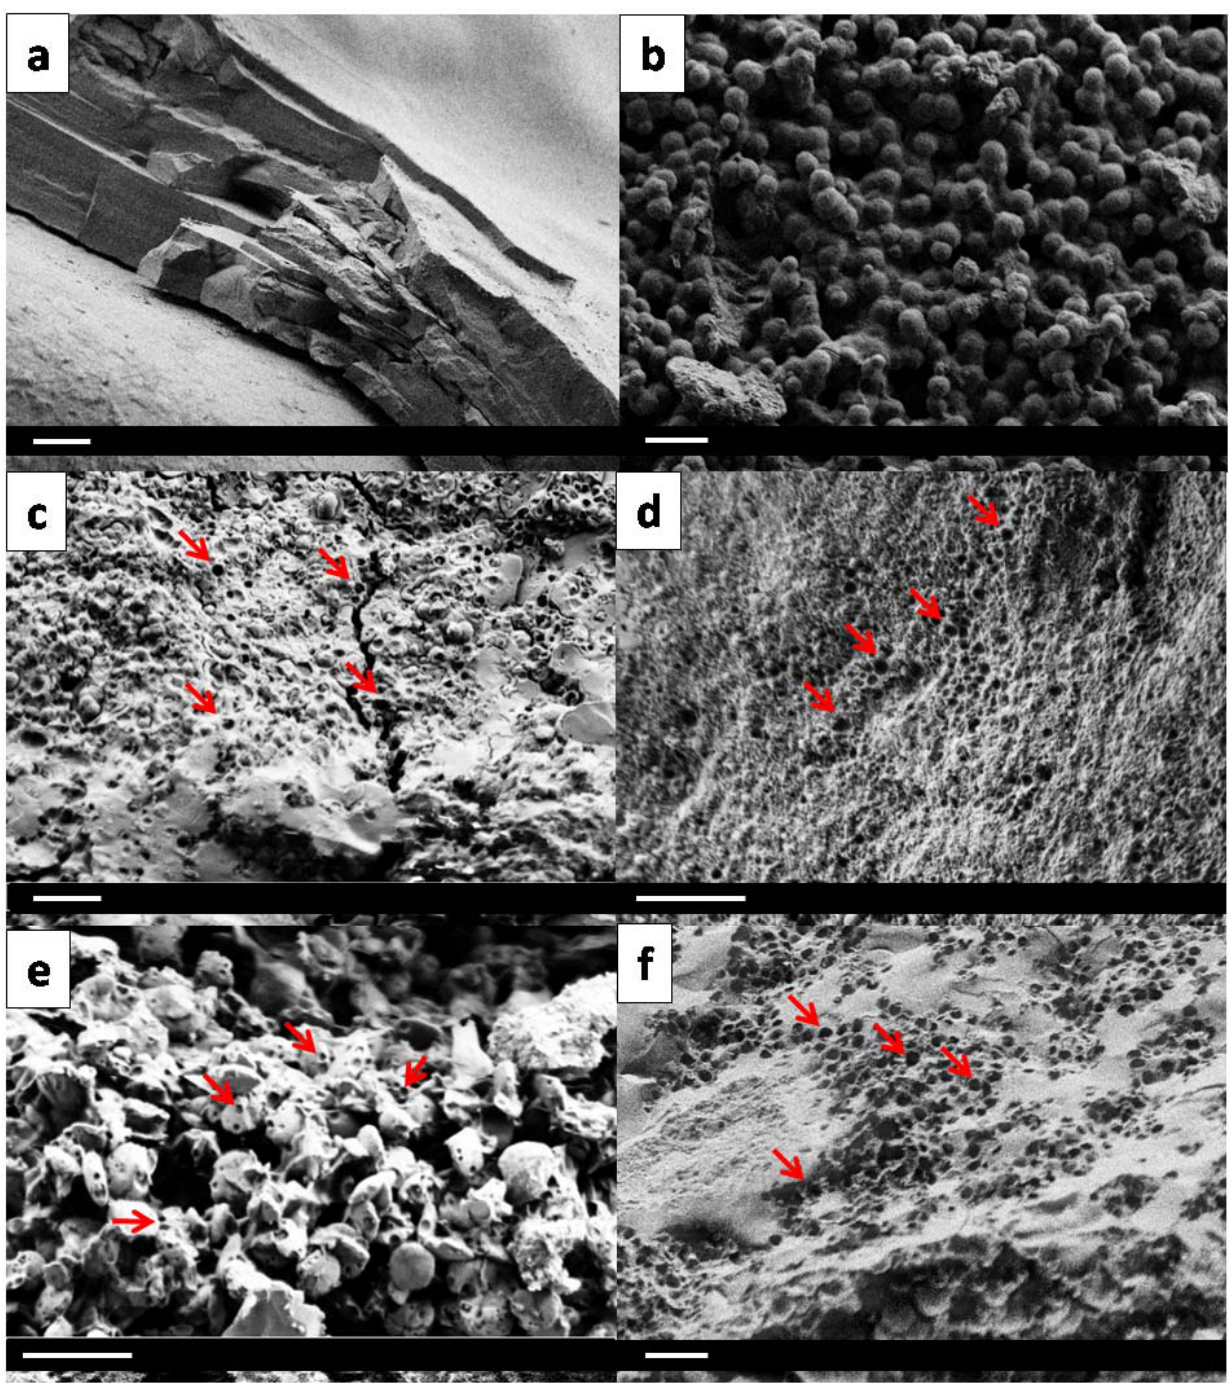
Figure 1. Fixed-effects SEM of prostatic stones. Red arrows show bacterial imprints. a) prostatic carbapatite-amorphous carbonated calcium phosphate (CA-ACCP) stone without any visible imprint; b) spherical prostatic CA stones without any visible imprint; c) prostatic CA-ACCP stone; d) prostatic ACCP stone, e) prostatic CA stone; f) prostatic CA-whitlockite stone. Bar, 4 m m.